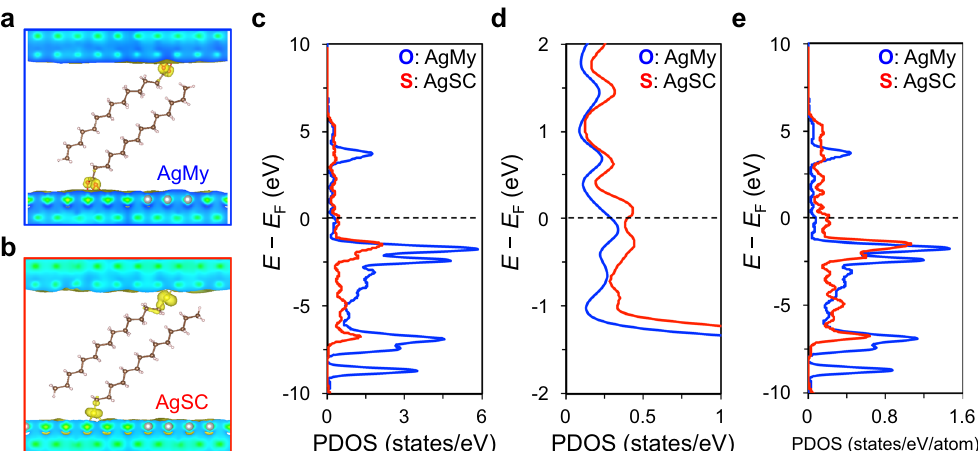
Fig. 3 Comparison between the electron partial density of states (PDOS) projected only for the O atom in AgMy and only for the S atom in AgSC. a , b Isosurfaces of the band decomposed charge density around the Fermi level (the squared wave function integrated from − 0.1 to 0.1 eV) calculated for a AgMy and b AgSC. The isovalue was set to 0.0005 in both systems. Each wave function is found to be localized at the interface between the anchor atoms and the surface. c PDOS values projected only for the O atoms in AgMy (blue) and only for the S atom in AgSC (red). On the whole, the PDOS of the O atoms exhibits a higher value than that of the S atom in the range from − 10 to 10 eV. d Expanded PDOS values for the O atom in AgMy (blue) and the S atom in AgSC (red) in the range from − 2 to 2 eV. These PDOS values clearly indicate that the difference in the DOS near the Fermi level between AgMy and AgSC shown in Fig. 2e is attributed to the anchor atoms. e PDOS values per atom for the O atom in AgMy (blue) and the S atom in AgSC (red). The difference in the PDOS values is much more noticeable.